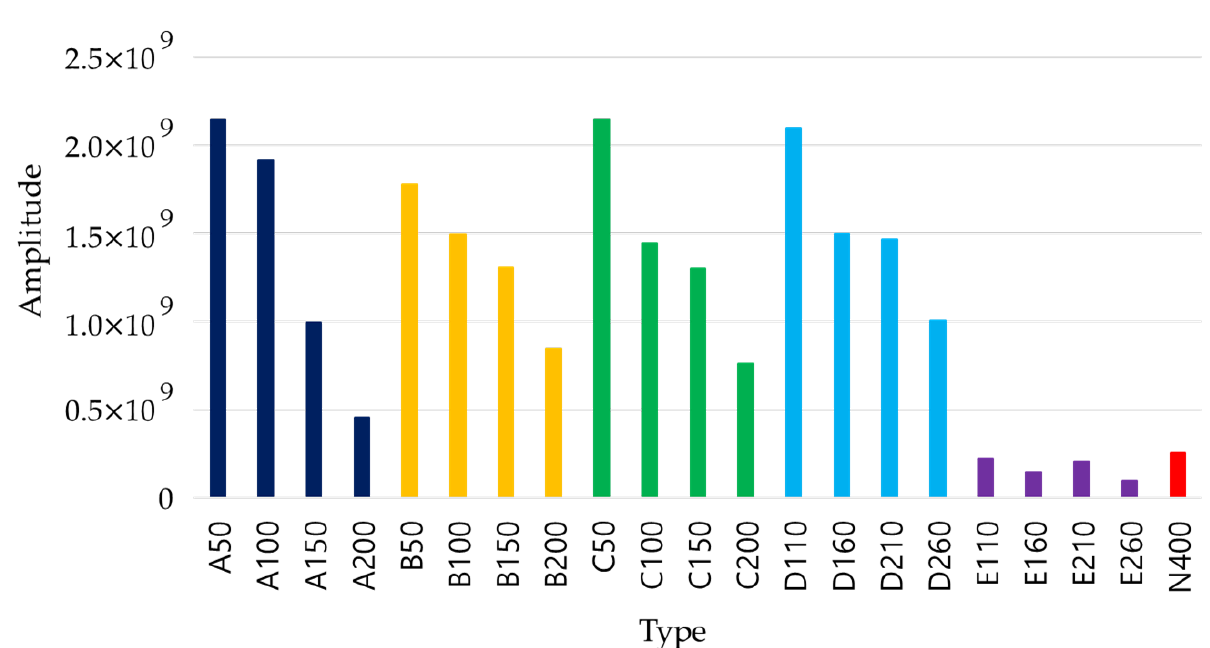
Figure 9. Comparison of attenuation for reflected waves of EM waves by type.